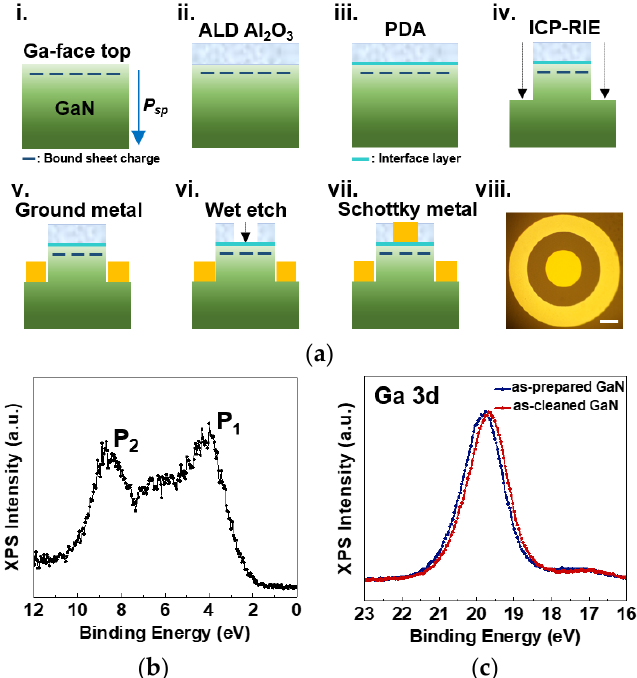
Figure 1. ( a ) Process steps for GaN Schottky diode (SD): (i) preparation, (ii) atomic-layer deposition (ALD) Al 2 O 3 , (iii) post-deposition annealing (PDA), (iv) mesa etching using inductively coupled plasma-reactive ion etching (ICP-RIE), (v) ground metal deposition, (vi) metal area formation through wet etch, (vii) Schottky metal deposition, and (viii) optical image of circular-shaped GaN SD (scale bar = 50 µm). ( b ) Characterization of surface polarity of GaN using X-ray photoelectron spectroscopy (XPS). ( c ) XPS spectra of Ga 3d core levels in as-prepared and as-cleaned GaN.